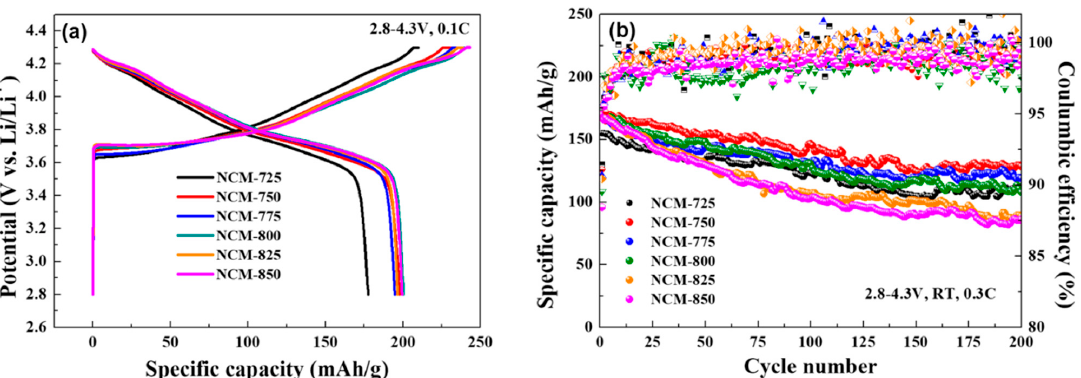
Table 1. Crystallographic data and BET surface area of SNCM cathodes.